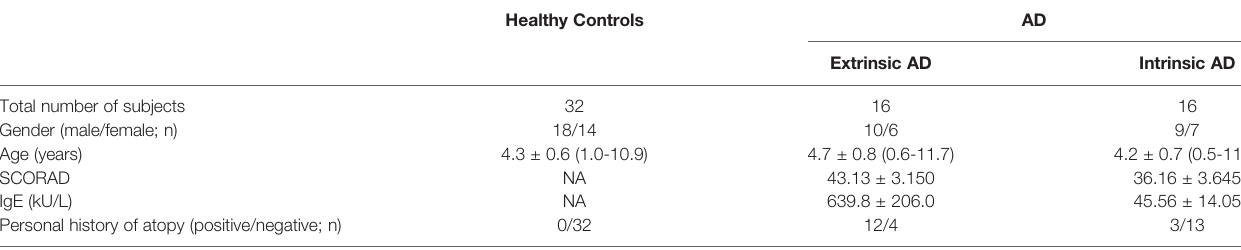
TABLE 1 | Clinical features and demographics of healthy controls and patients with AD.